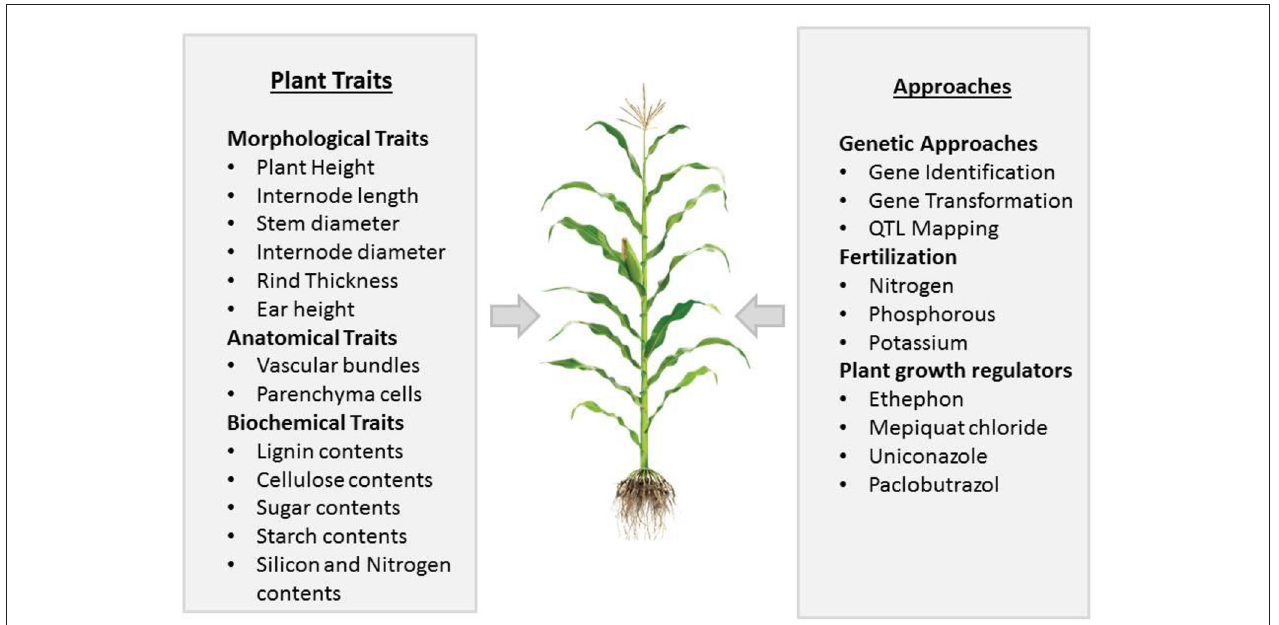
FIGURE 1 | Summary of different plant traits and approaches important in affecting stem lodging and kernel abortion in